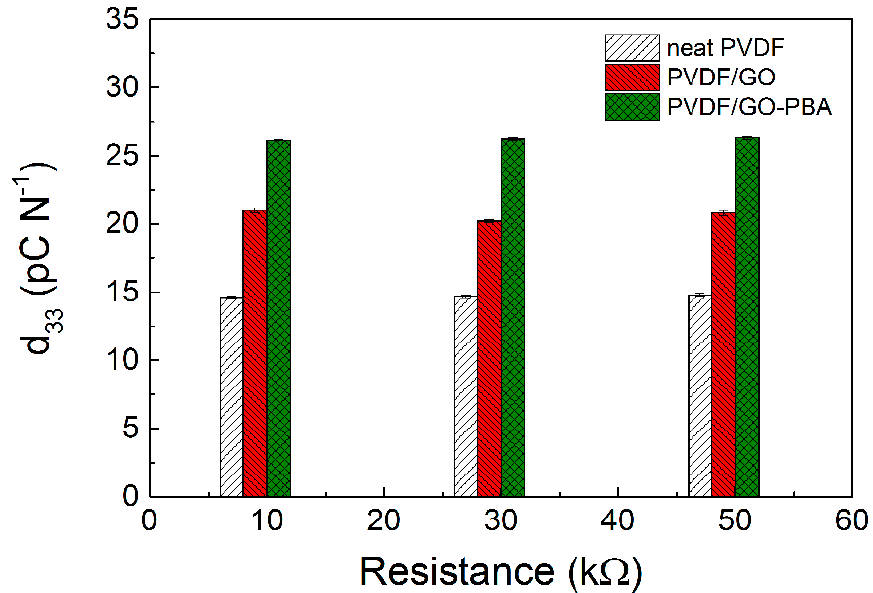
Figure 13. Identification of the d 33 piezoelectric constant at various resistances for neat PVDF, PVDF/GO and PVDF/GO-PBA.